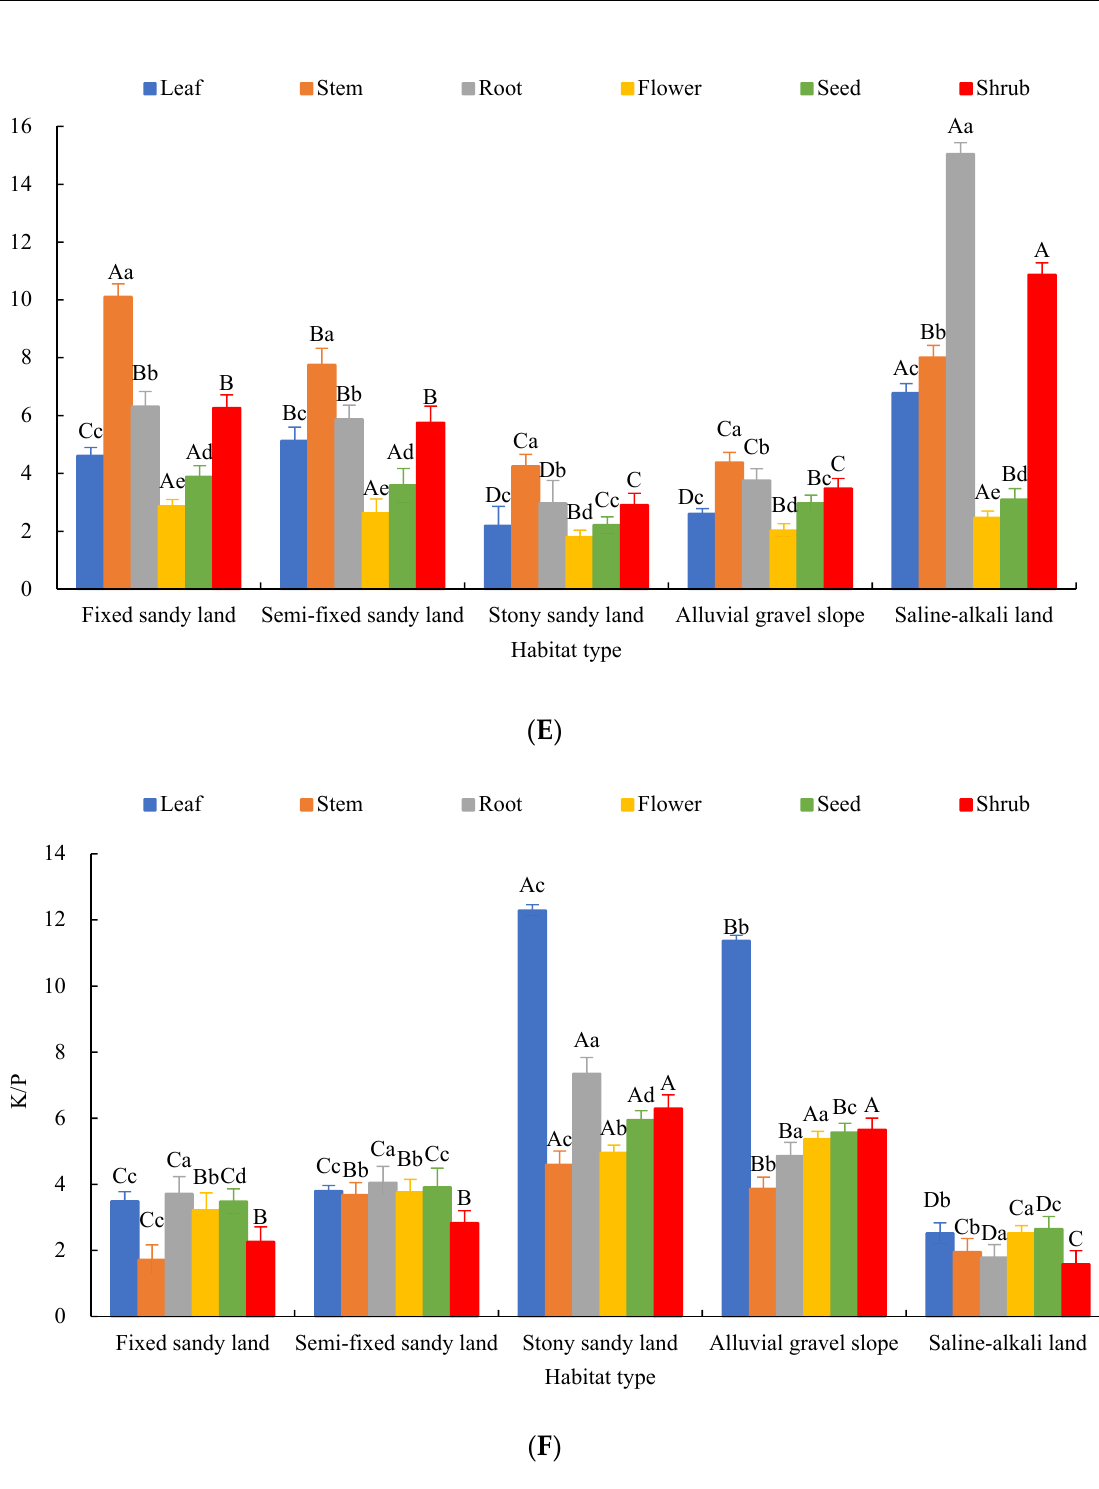
Figure 2. Elemental stoichiometric ratios in the organs of A. mongolicus in different habitats. ( A ) C/N, ( B ) C/P, ( C ) C/K, ( D ) N/P, ( E ) N/K and ( F ) K/P were all element stoichiometric ratios. Note: Upper case letters represent significant differences in different habitats of the same organ ( p < 0.05). Lower case letters represent the significant characteristics of different organs in the same habitat ( p < 0.05).